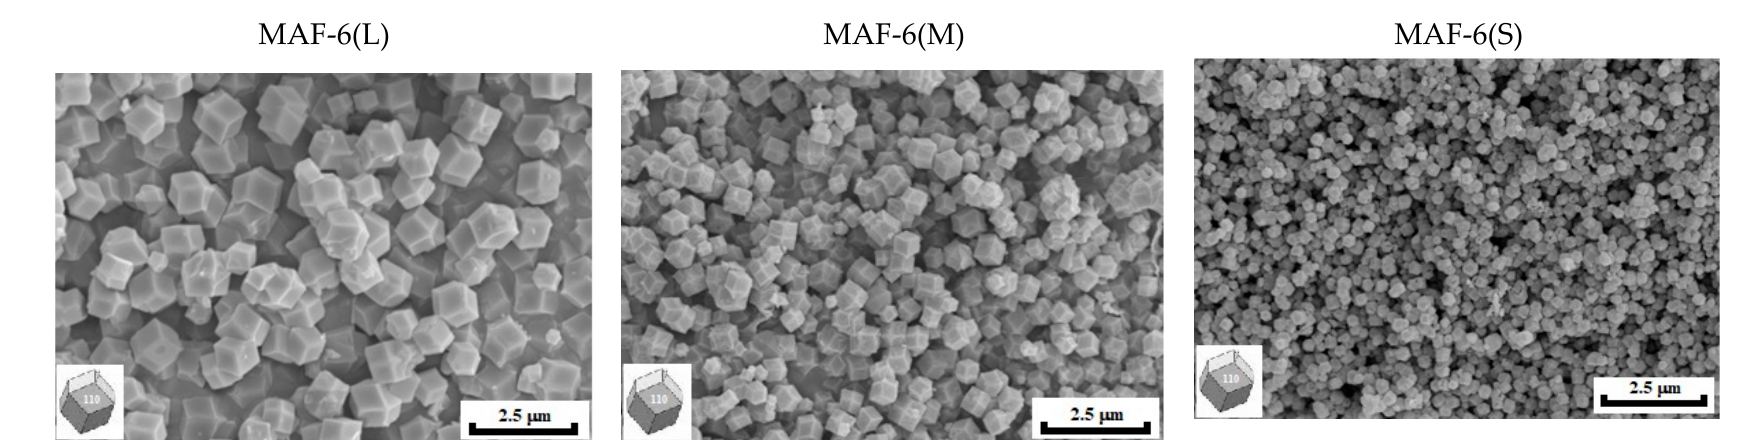
Figure 1. SEM images of MAF-6 samples with different particle sizes.